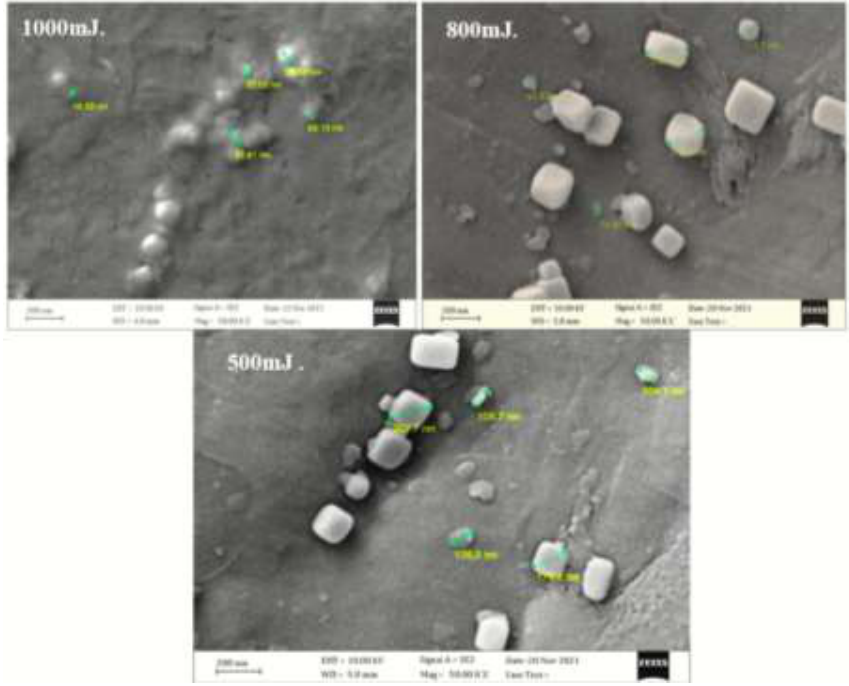
Figure 5 : SEM image of Al 2 O 3 NPS at (A) 500mJ, (B) 800mJ, (C) 1000mJ